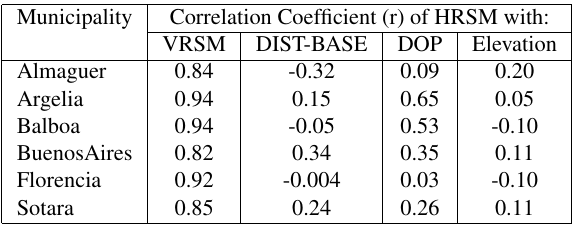
Table 8: Linear relations between the average horizontal error of